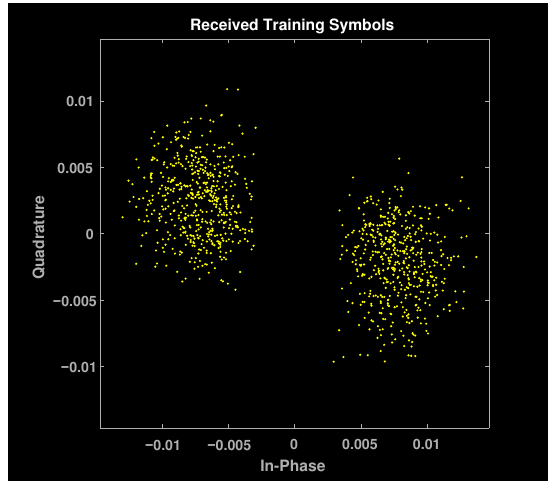
Figure 17. Received training symbols after CFO correction.